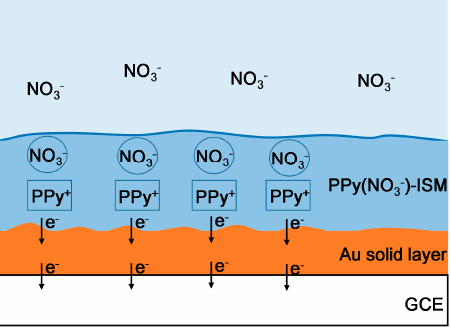
Figure 11. Schematic diagram of the NO 3 − response procedure for the PPy-Au-NS ISE.